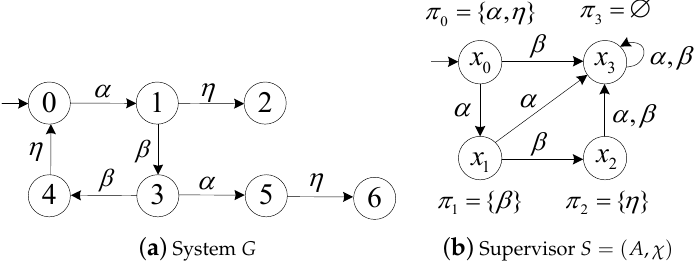
( b ) Supervisor S = ( A , χ )